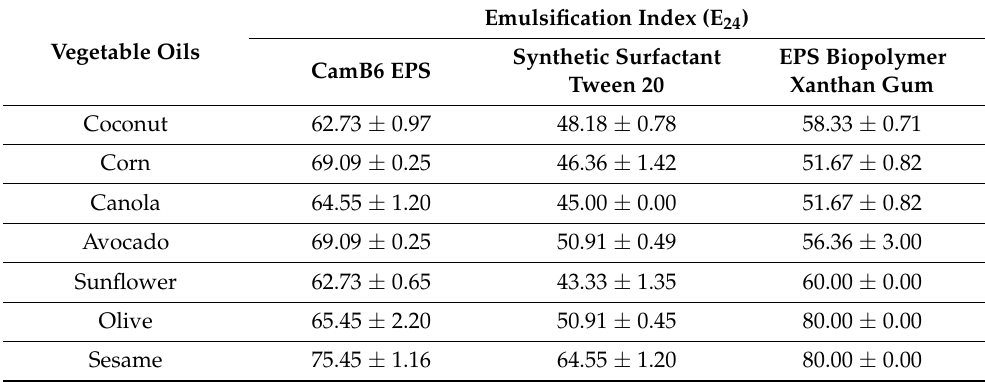
Table 3. The emulsifying activity of the EPS produced by B. haynesii CamB6 in different vegetable oils compared to commercial EPS biopolymer and synthetic